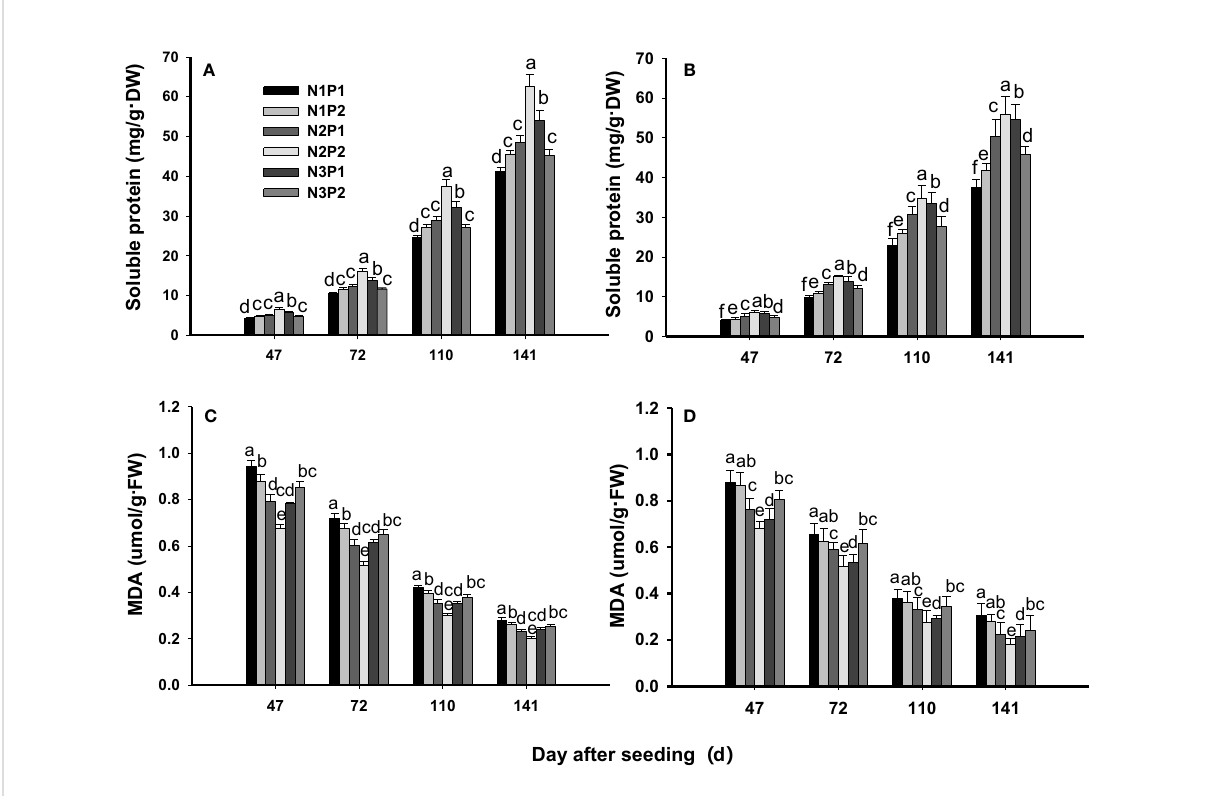
FIGURE 5 Effects of different nitrogen and phosphorus combinations on contents of soluble protein and malondialdehyde (MDA) of sesbania pea at different growth stages. Different letters indicate signi fi cant differences between different treatments at same growth stage at P <0.05 level. (A, C) : 2020; (B, D) :